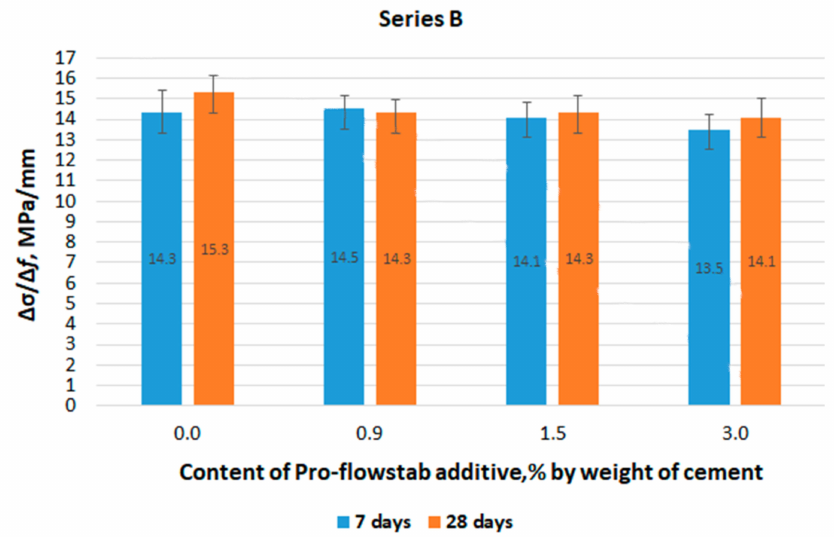
Figure 8. The value of the ratio ∆ σ / ∆ f in the bending test of series B specimens, depending on the age of the specimens and the Pro-Flowstab additive